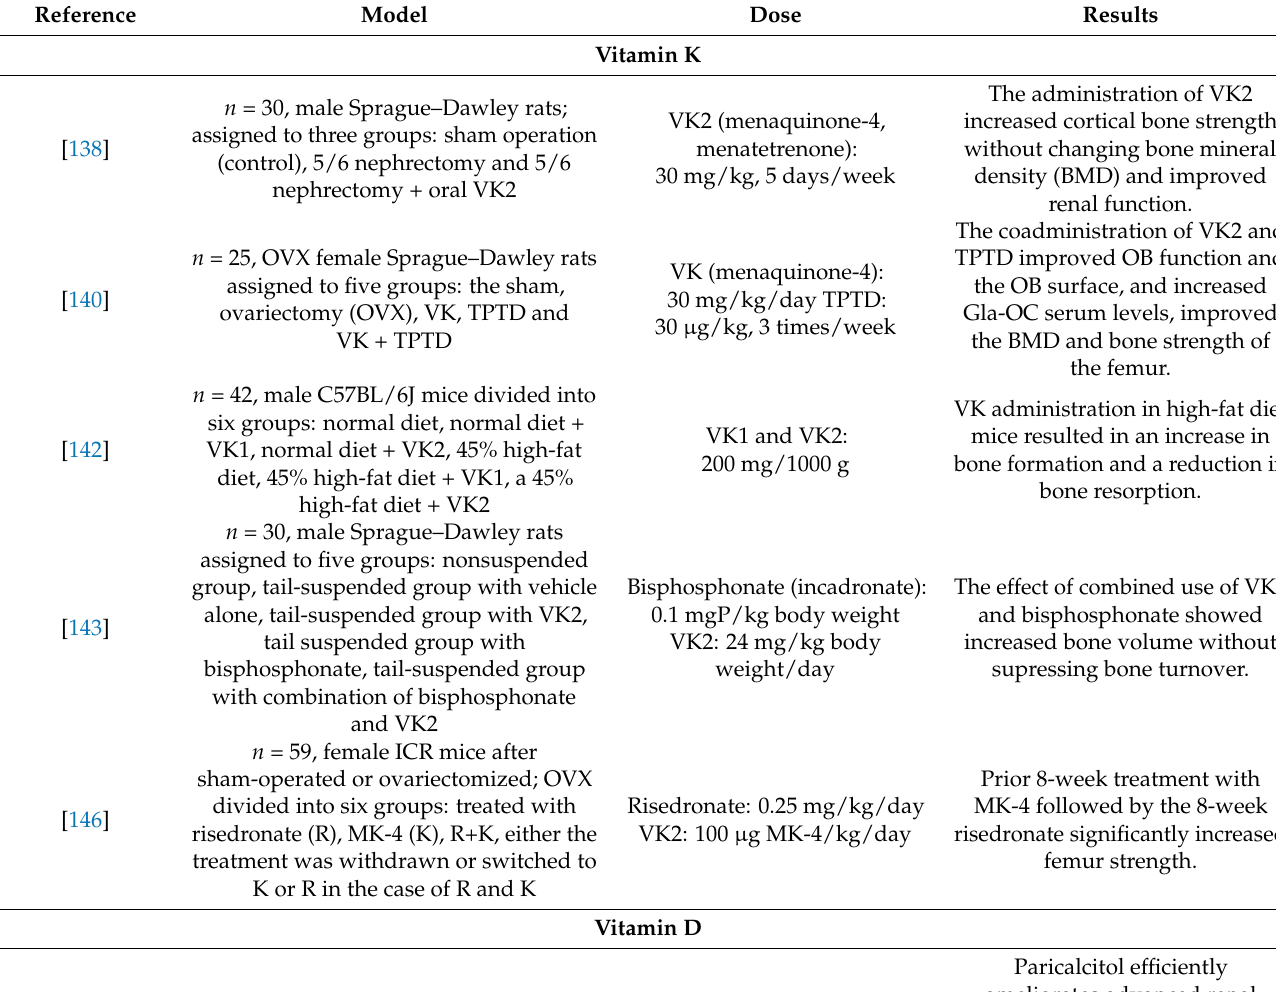
Table 2. Vitamin K and vitamin D in bone remodeling—in vivo